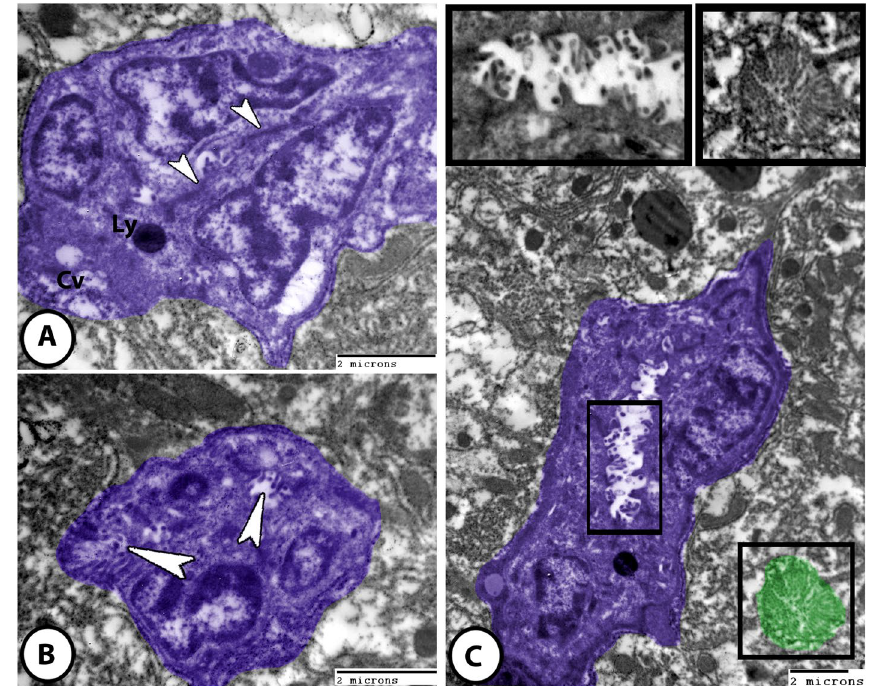
Fig. 8 Digitally colored TEM images of the liver in molly fish. A The bile ductule lined with epithelial biliary cells (dark blue) that were connected to each other by desmosomes and tight junction (arrowheads). The biliary cells showed cytoplasmic vacuoles (Cv) and lysosomes (Ly). B The apical surface of the biliary cells showed numerous microvilli (arrowheads), which were projected into the bile ductules. C Bile duct (dark blue) lined by high cuboidal cells with prominent microvilli projected into the duct lumen (square boxed areas). Bile canaliculi (green) located between hepatocytes showed numerous microvilli (rectangle boxed